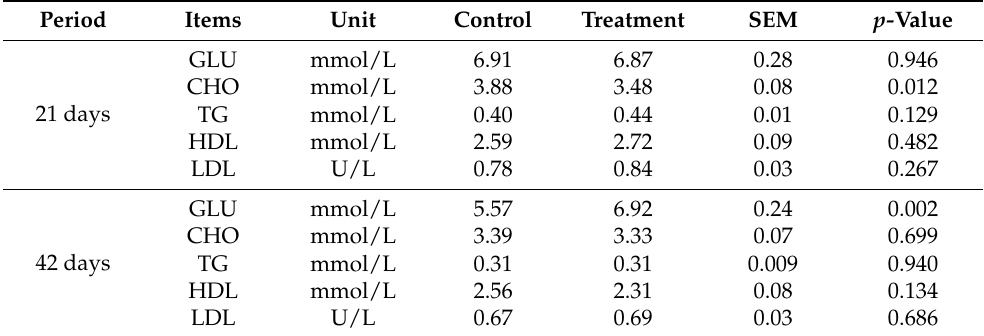
Table 5. Effects of lecithin on the serum biochemical parameters of broilers at 21 and 42 days 1 . Period Items Unit Control Treatment SEM p- Value GLU mmol/L 21 days